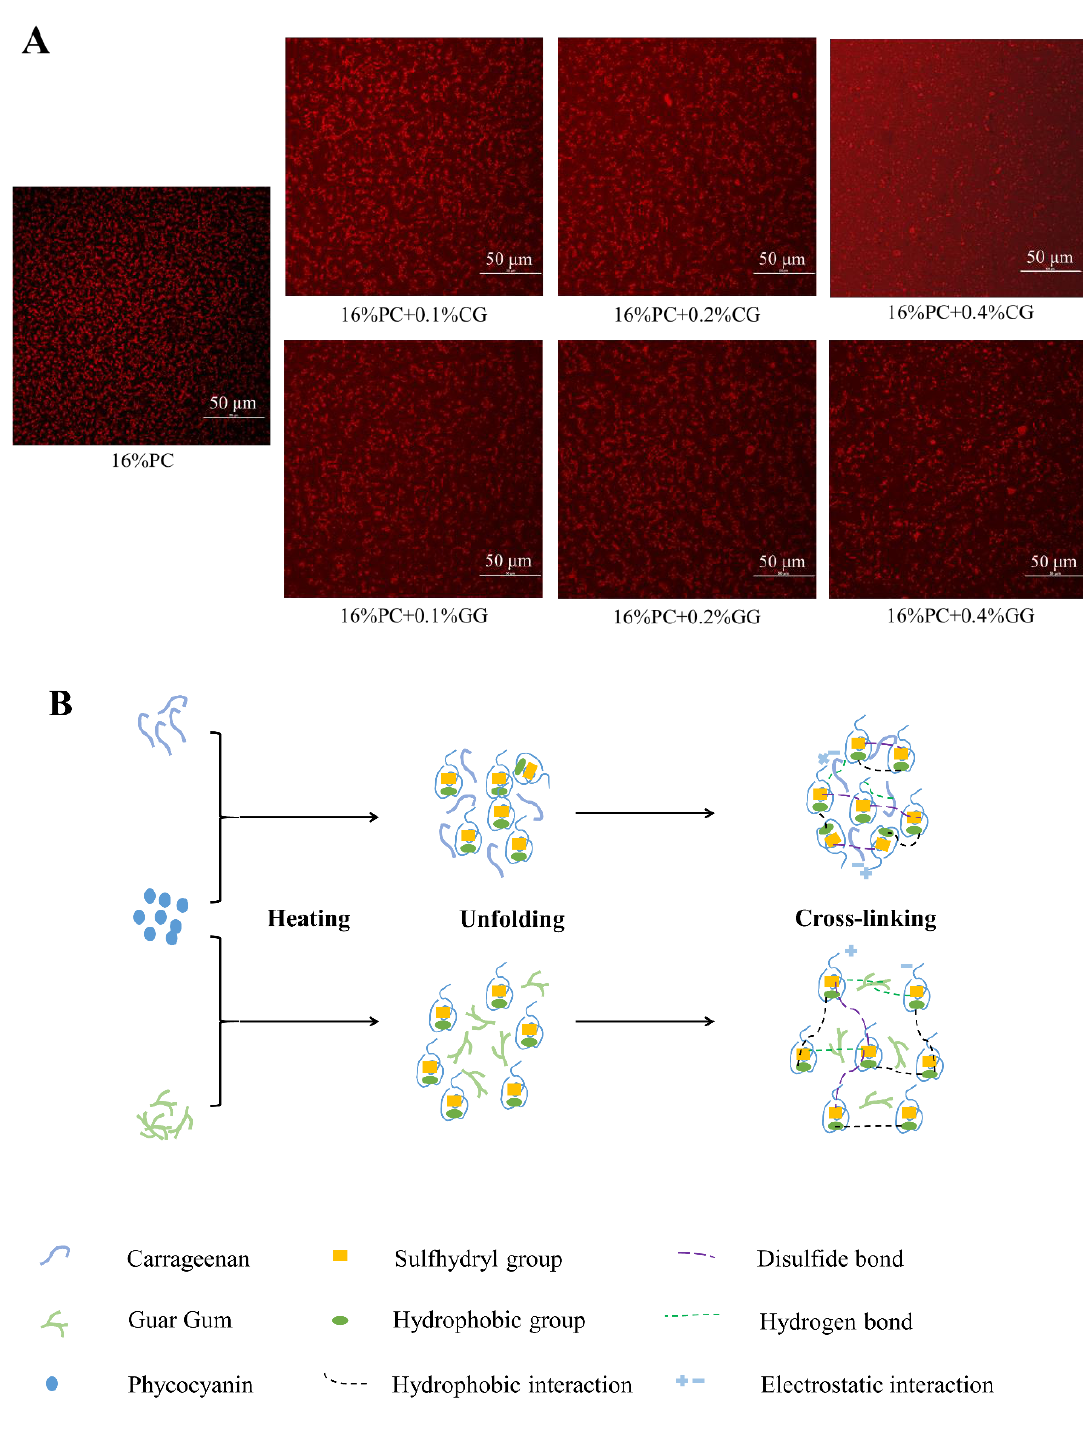
Figure 7. The effect of κ -carrageenan/guar gum addition on the microstructure of phycocyanin gel ( A ); (scale bar: 50 µ m, red represented phycocyanin, black represented polysaccharide or water); Schematic diagram of PC-CG gels and PC-GG gels ( B ).